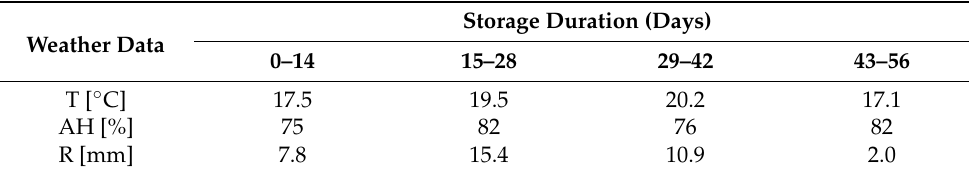
Table 2. Mean temperature, air humidity and rainfall for storage duration.